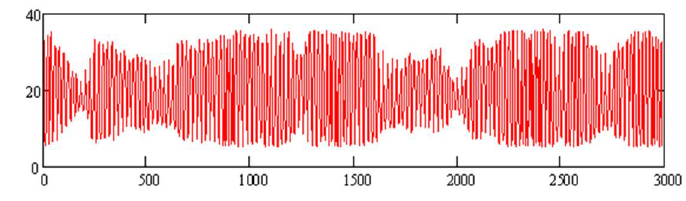
Figure 8. Experimental load